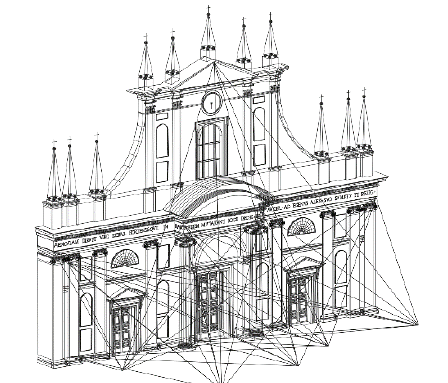
Figure 15 – S.Maria dell’Orto by Vignola (1566), the plot and the arrangement of the 5 panoramas (by G.Rubeca).